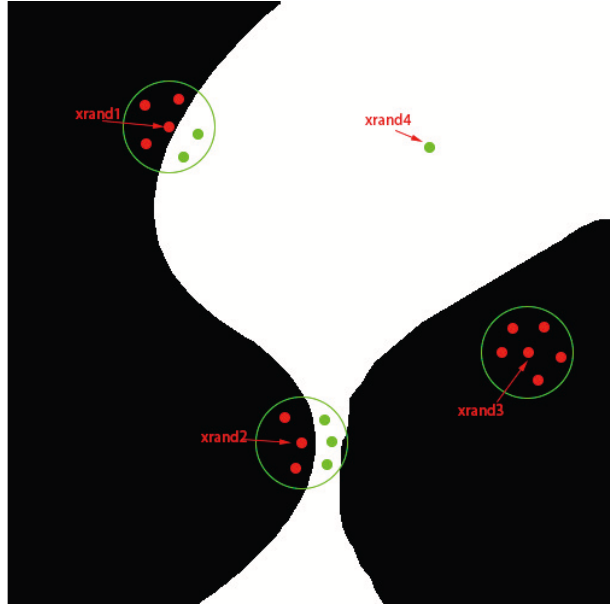
Figure 3. Locally sample around xrand . xrand 1, xrand 2, xrand 3, and xrand 4 show four different cases, respectively. When there are sampling points in the free space in the local sampling, such as xrand 1 and xrand 2, then the surrounding environment of xrand is further judgments, xrand 3 and xrand 4 will not make further judgments.